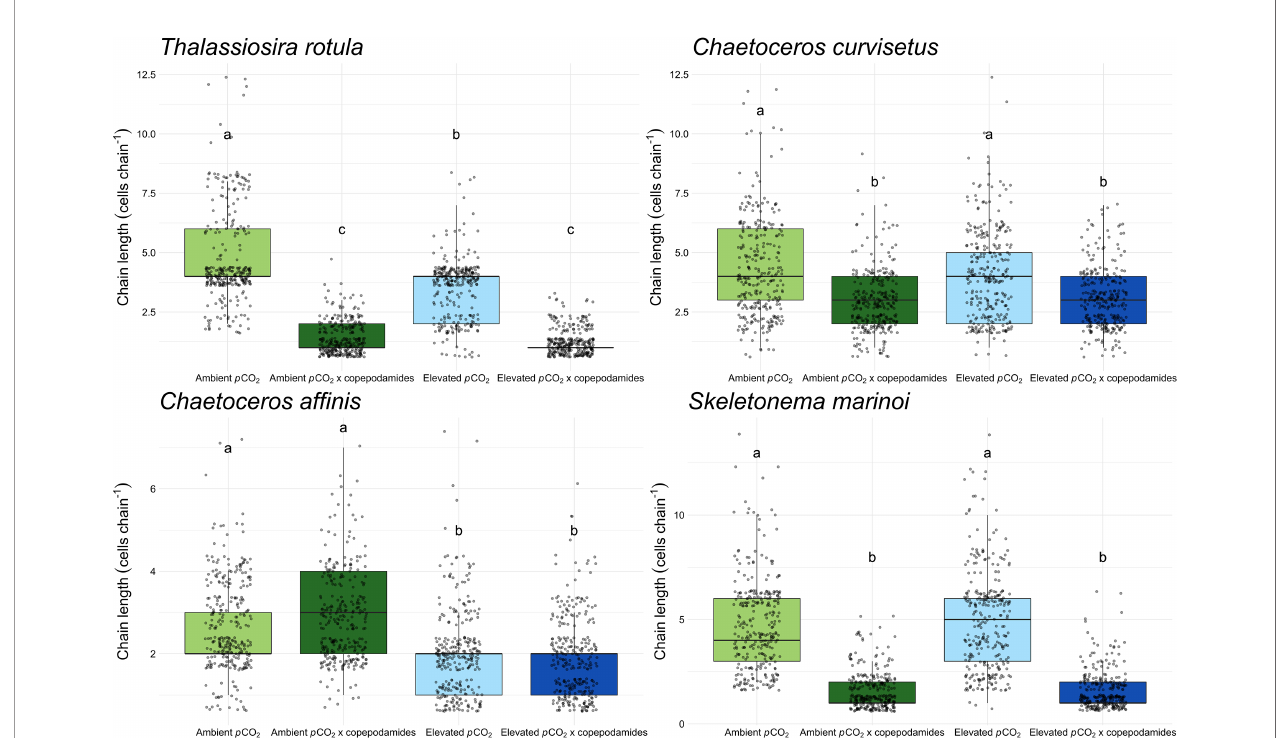
FIGURE 2 | Boxplots showing chain length of four species of chain-forming diatoms ( T. rotula, C. curvisetus, C. af fi nis, S. marinoi ) after 48 hours of exposure to one of four treatments ( “ ambient p CO 2 ” , “ ambient p CO 2 x copepodamide ” , “ elevated p CO 2 ” or “ elevated p CO 2 x copepodamide ” ). In total, 300 observations were made per species and treatment (6 replicates of 50 chain length measurements). Solid line inside the box signi fi es the median, box contains the lower and upper quartile ranges, and dots represent individual observations; letters denote signi fi cance ( p < 0.05), n =